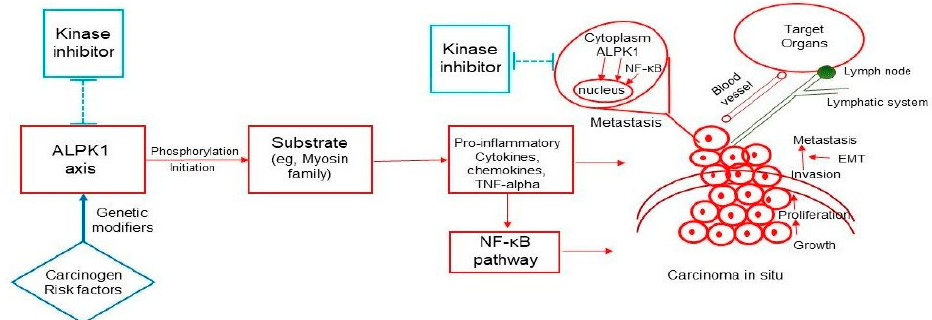
Figure 2. The mechanisms and pathways of ALPK1-related cancer development and metastasis. TNF- α and NF- κβ are the primary mechanisms through which the novel ALPK1 pathway contributes to cancer. In the initial stage, ALPK1 acts upstream to regulate TNF- α , which then activates NF- κ B-associated cancers. During the progression stage, a novel pathway involves ALPK1 translocation to the nucleus to promote cancer cell invasion and metastasis through the epithelial–mesenchymal transition (EMT).